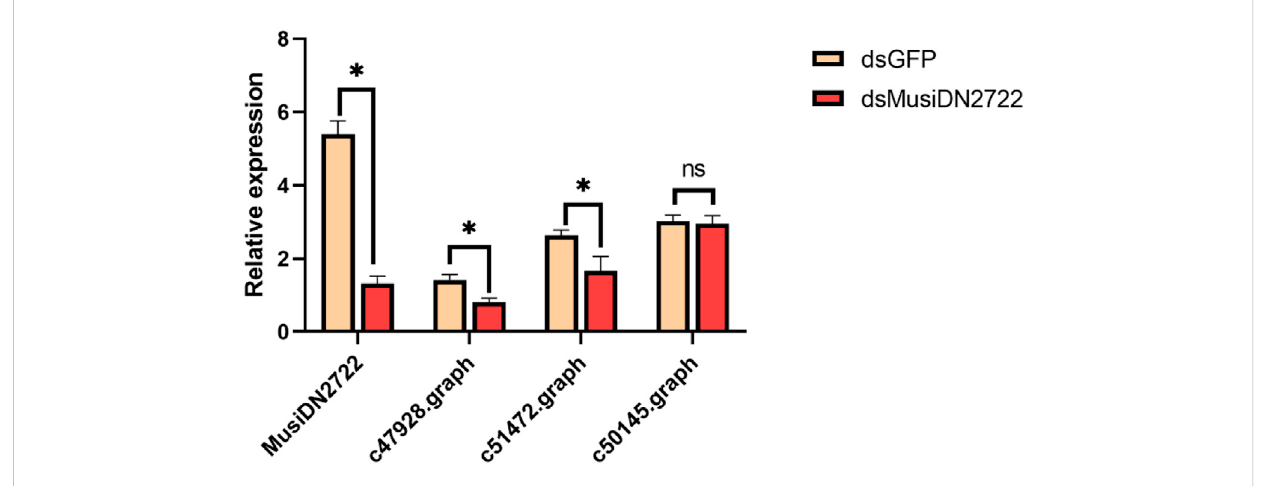
FIGURE 9 Expression of related genes after silencing of target